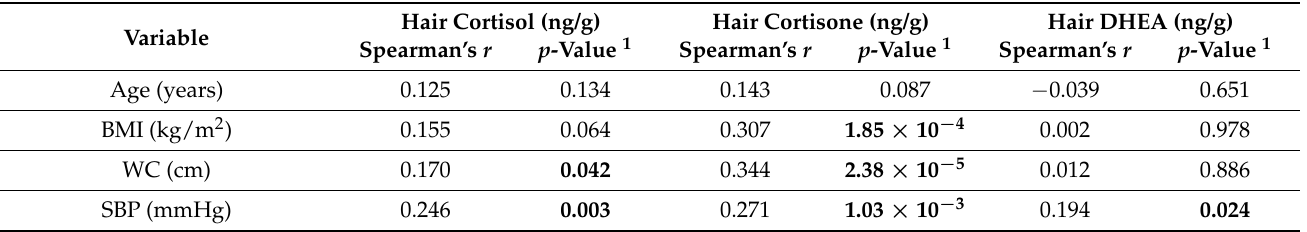
Figure 1. Correlations between hair steroid hormone levels and SCORE2 index (r s —Spearman‘s correlation coefficient, statistically significant p -values are bolded). Table 5. Correlations between hair steroid hormone levels and age, anthropometric indicators and glucose and lipid metabolism